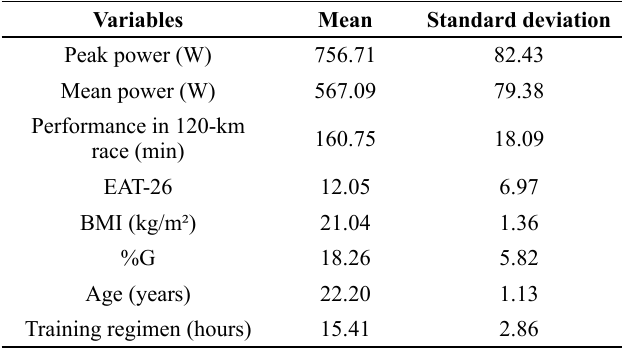
Table 1 Descriptive values (mean/standard deviation) of study vari- ables.